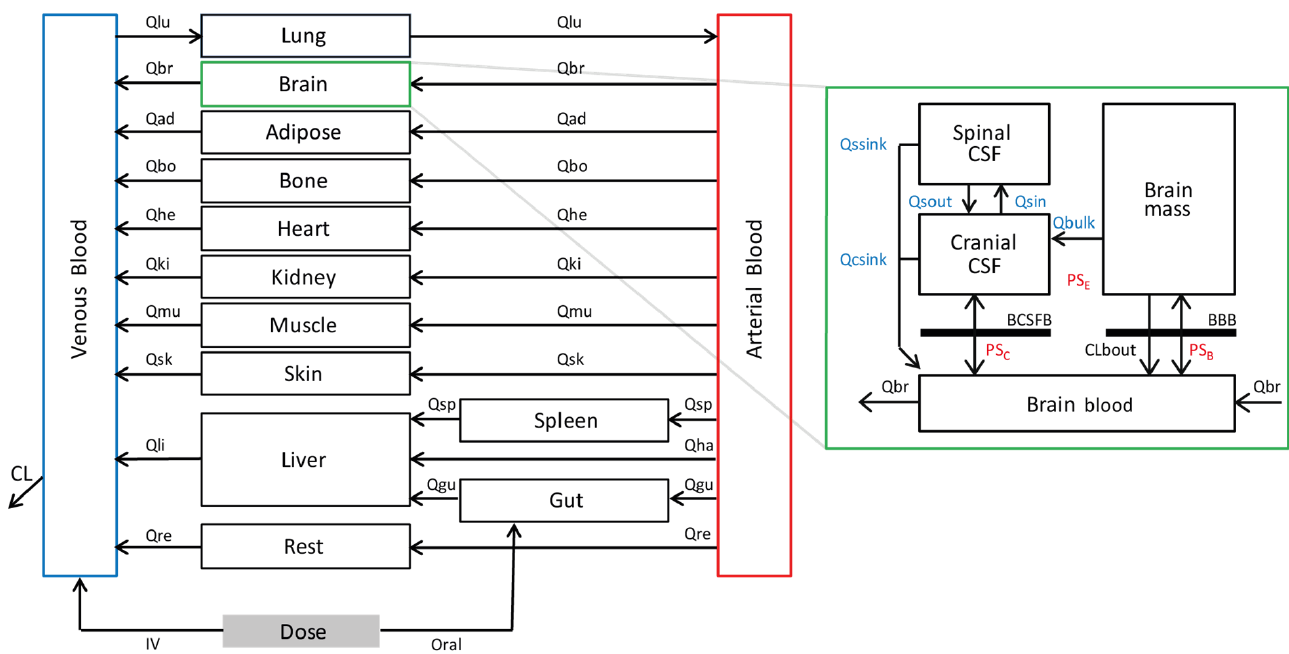
Figure 1. Schematic outline of the PBPK model, including four CNS compartments, adapted from Verscheijden et al. (2019) [20], with permission. Qsin and Qsout represent CSF shuttle flow between cranial CSF and spinal CSF compartments. Qssink and Qcsink are the flows from CSF compartments to blood. Qbulk represents bulk flow from brain mass to cranial CSF. PSB, PSC, and PSE represent permeability surface area products between brain blood and brain mass, brain blood and cranial CSF, and brain mass and cranial CSF, respectively. CLbout represents overall clearance of efflux transporters P-gp and BCRP expressing at BBB. Subscripts lu, br, ad, bo, he, ki, mu, sk, li, re, gu, sp, and ha denote lung, brain, adipose tissue, bone, heart, kidney, muscle, skin, liver, rest tissue, gut, spleen, and hepatic artery, respectively. CL is the total clearance from the model. IV is an intravenous dose, and oral is an oral dose route of administration.